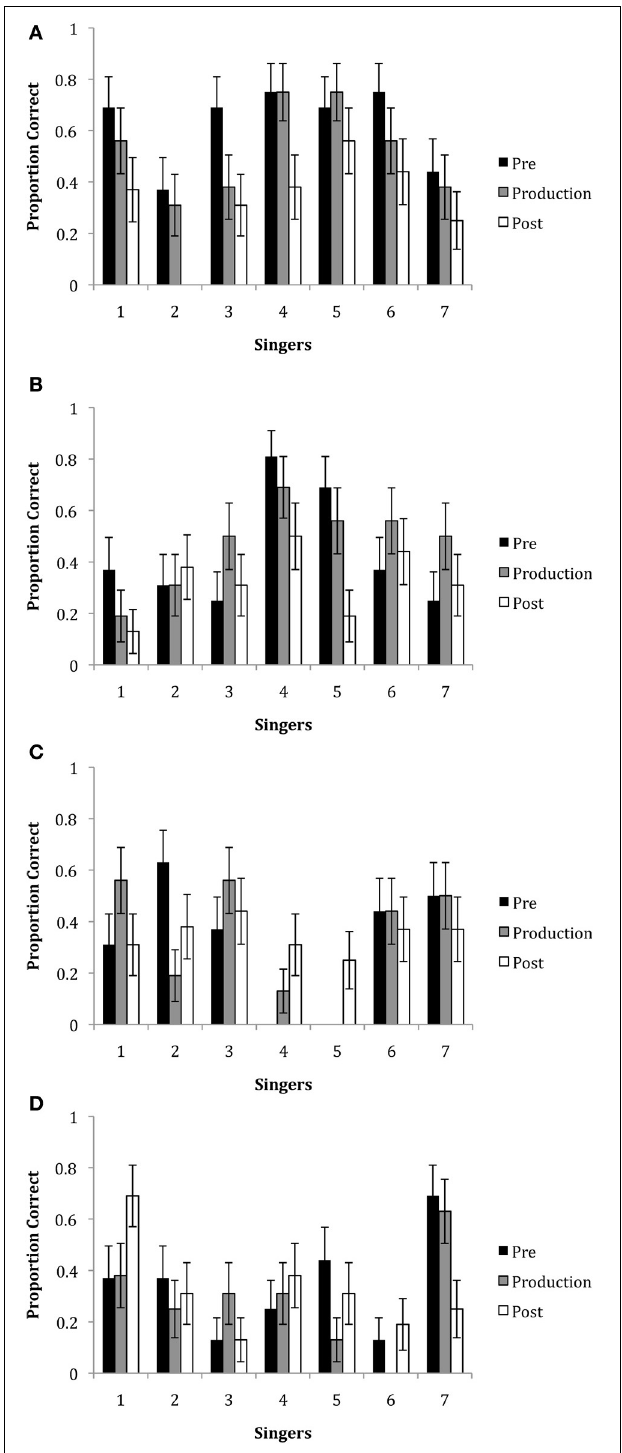
FIGURE 6 | The proportion of correct responses for the emotions of (A) happiness, (B) irritation, (C) neutral and (D) sadness for each of the seven singers in each of the three epochs using the exaggerated stimuli. Note that missing bars indicate that no participant accurately decoded the emotional